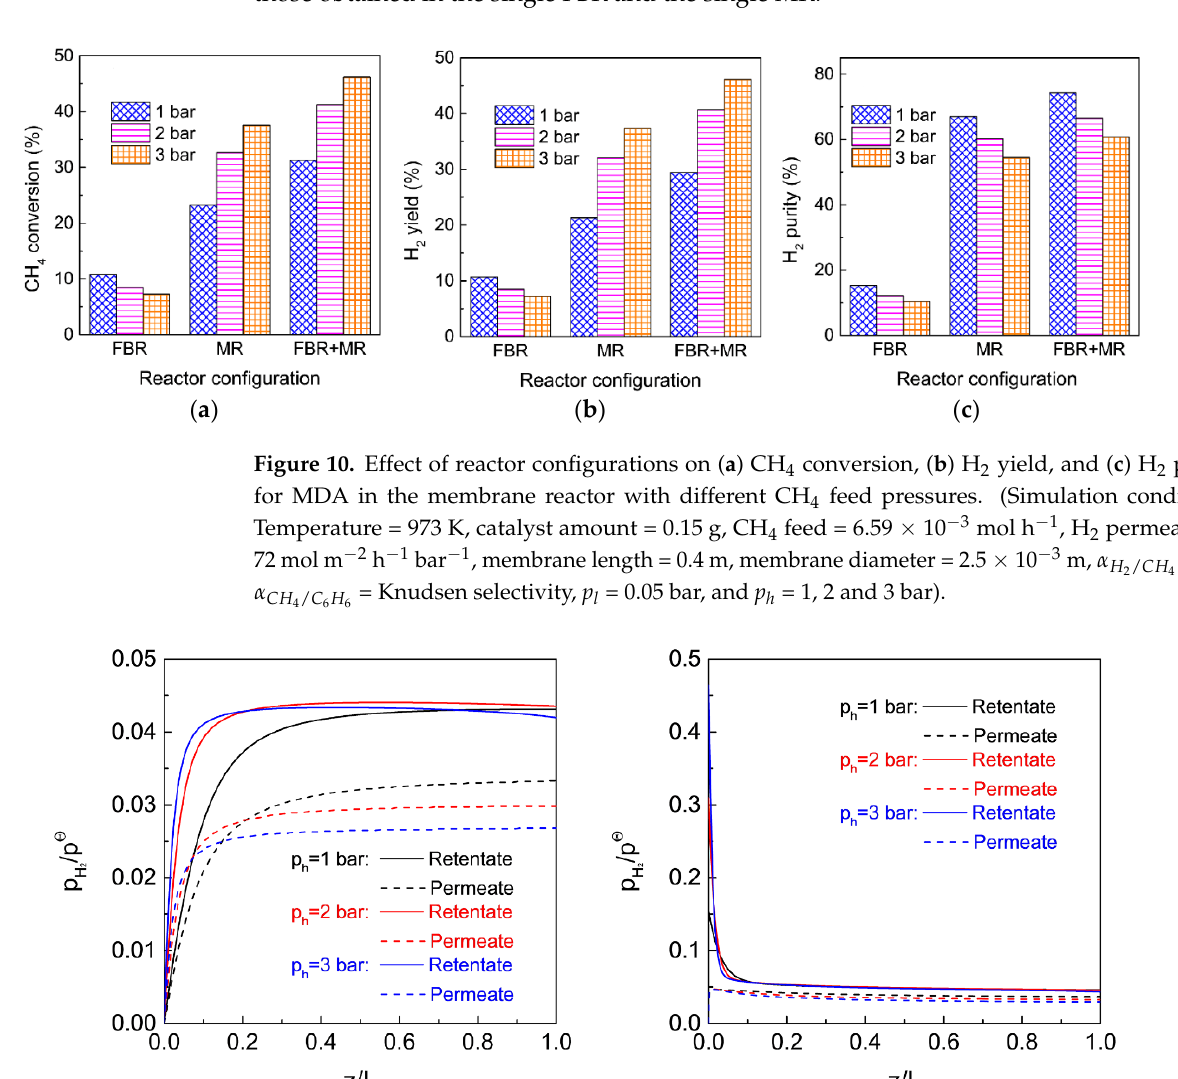
Figure 11. Axial profiles of H 2 partial pressure normalized by the standard pressure for MDA in the membrane reactor under different feed pressures ( a ) with and ( b ) without the assistance of a pre-reactor. (Simulation conditions: Temperature = 973 K, catalyst amount = 0.15 g, CH 4 feed = 6.59 × 10 −3 mol h −1 , H 2 permeance = 72 mol m −2 h −1 bar −1 , membrane length = 0.4 m, membrane diameter = 2.5 × 10 −3 m, α H = 200, α CH = Knudsen selectivity, p l = 0.05 bar, 2 / CH 4 4 / C 6 H 6 and p h = 1, 2 and 3